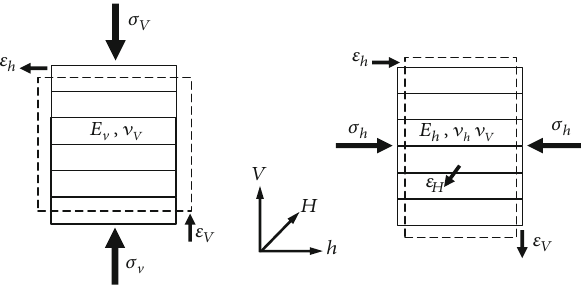
Figure 3: A vertical transversely isotropic rock showing Poisson ’ s ratios and Young ’ s moduli in two di ff erent loading